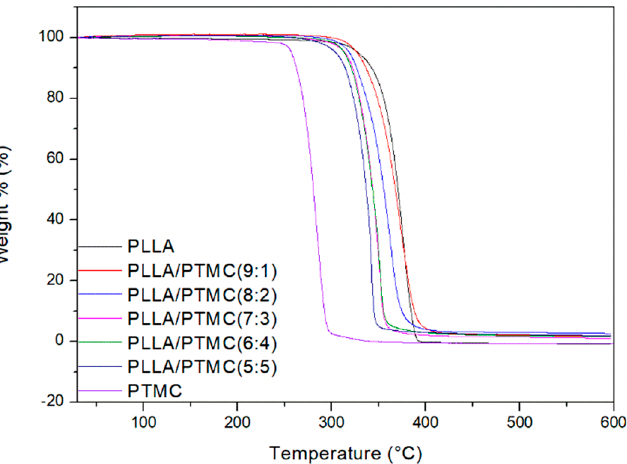
Figure 4. Results of thermogravimetric analyses conducted on PLLA/PTMC blend membranes characterised by different blending ratios. PLLA: poly(L-lactide); PTMC: poly(trimethylene